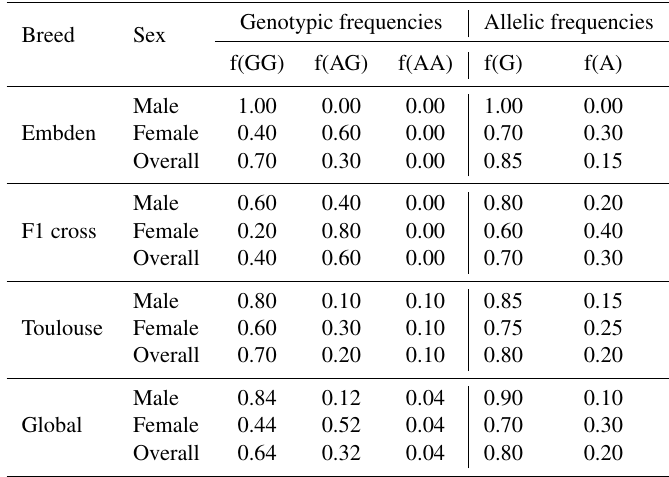
Table 1. Genotypic and allelic frequencies of polymorphism g.68G → A (CAPN1 gene) in the three goose subpopulations and in the global